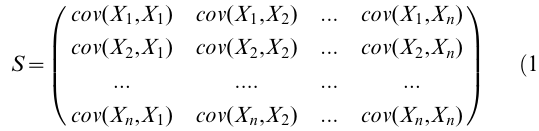
Figure 1. The SIDD profiles of the plasmid pmj115 alone, and when inserted in nine different genomic contexts. Only the profile of the plasmid itself is shown here; G ( x ) is measured in units of